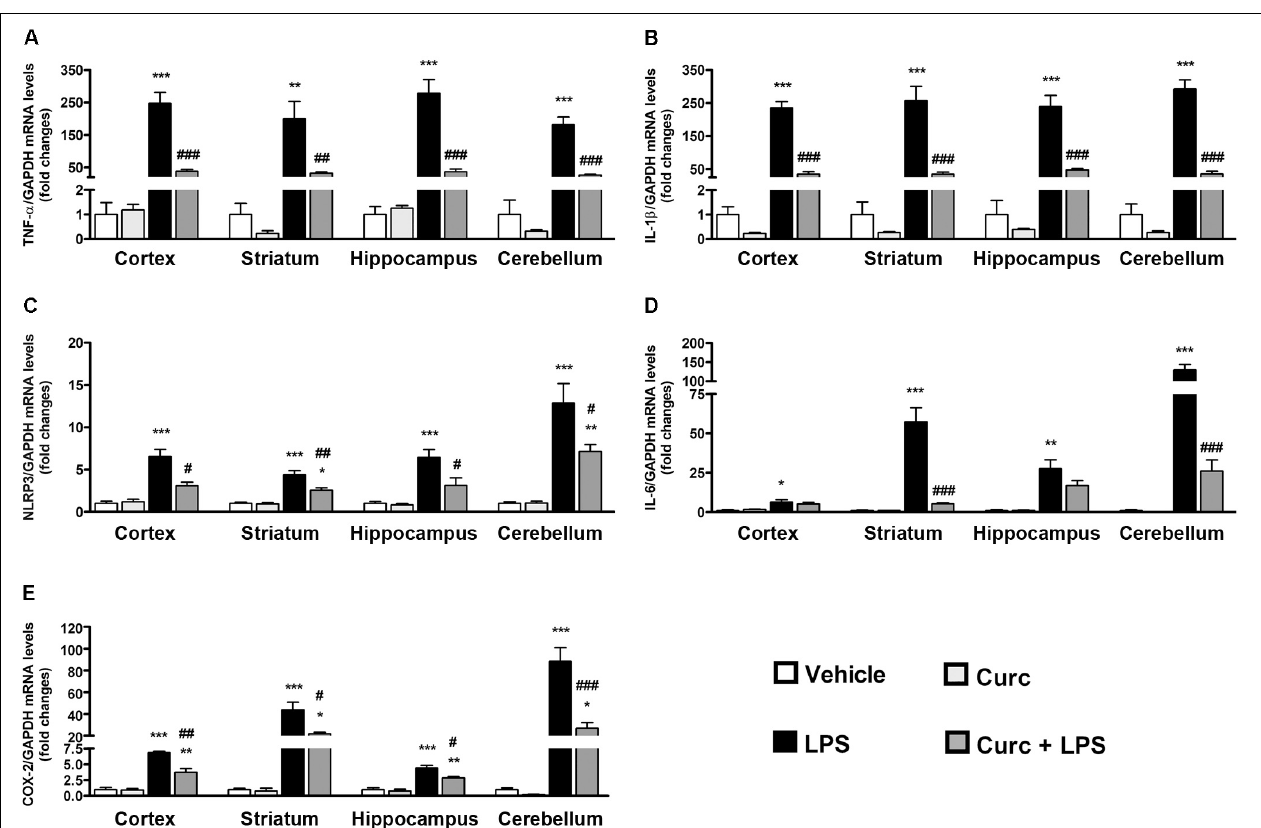
FIGURE 2 | Curcumin inhibits the acute brain pro-inflammatory response to peripheral LPS administration. Mice treated for 2 consecutive days with curcumin (curc; 50 mg/kg) received a single i.p. injection of LPS (5 mg/kg). Two hours following LPS or saline injection, mice were sacrificed and cerebral cortex, striatum, hippocampus, and cerebellum were extracted and prepared as described in Section “Materials and Methods.” (A) Analysis of TNF- α mRNA expression levels was conducted via real-time PCR. Results are expressed as fold-increase with respect to control (vehicle only). Data are means ± SEM ( n = 4 mice/group). Data were analyzed by one-way ANOVA [ F ( 15 , 48 ) = 32.89, p < 0.0001] followed by Bonferroni’s multiple comparison test. ∗∗∗ p < 0.001 vs. control group; ## p < 0.01 and ### p < 0.001 vs. LPS-stimulated group. (B) Analysis of IL-1 β mRNA expression levels was conducted via real-time PCR. Results are expressed as fold-increase with respect to control (vehicle only). Data are means ± SEM ( n = 4 mice/group). Data were analyzed by one-way ANOVA [ F ( 15 , 48 ) = 59.32, p < 0.0001] followed by Bonferroni’s multiple comparison test. ∗∗∗ p < 0.001 vs. control group; ### p < 0.001 vs. LPS-stimulated group. (C) Analysis of NLRP3 mRNA expression levels was conducted via real-time PCR. Results are expressed as fold-increase with respect to control (vehicle only). Data are means ± SEM ( n = at least 4 mice/group). Data were analyzed by one-way ANOVA [ F ( 15 , 54 ) = 26.21, p < 0.0001] followed by Bonferroni’s multiple comparison test. ∗∗∗ p < 0.001 vs. control group; # p < 0.05